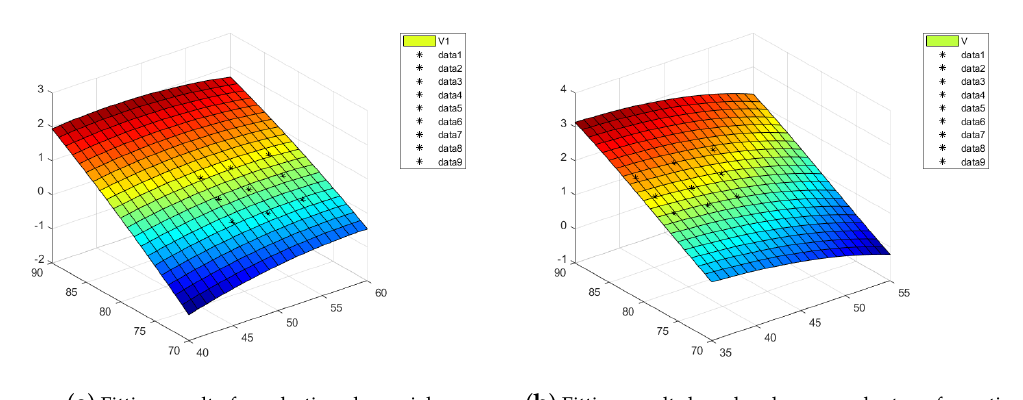
Figure 11. Schematic diagram of gaze point ordinate surface fitting.